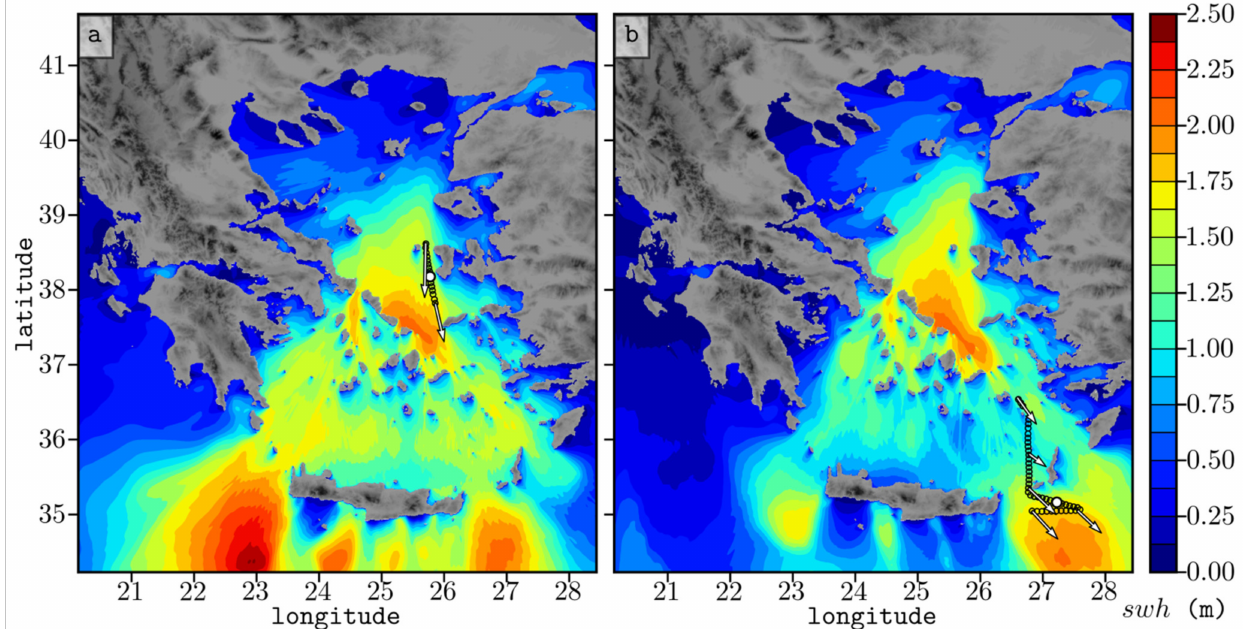
Figure 2. ( a ) Spatial distribution of significant wave height swh, on 7 September 2011 at 13:00 UTC, and ( b ) on 9 September 2011 at 10:00 UTC. Empty black circles illustrate spatially two flight segments, ( a ) at east-central AS and ( b ) at southeast AS; the white arrows illustrate the corresponding wind vector; black and white circles indicate the location of the spectrum displayed in Figure